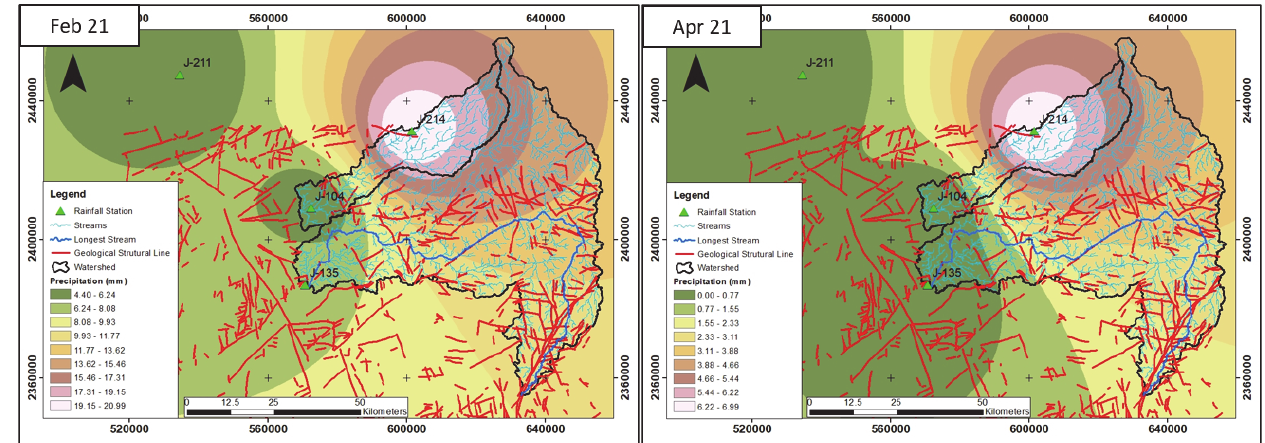
Figure 23. The rainfall contours projected over the fractures map to show the case of no extra recharge from the southern watershed into Al ‐ Lusub watershed.